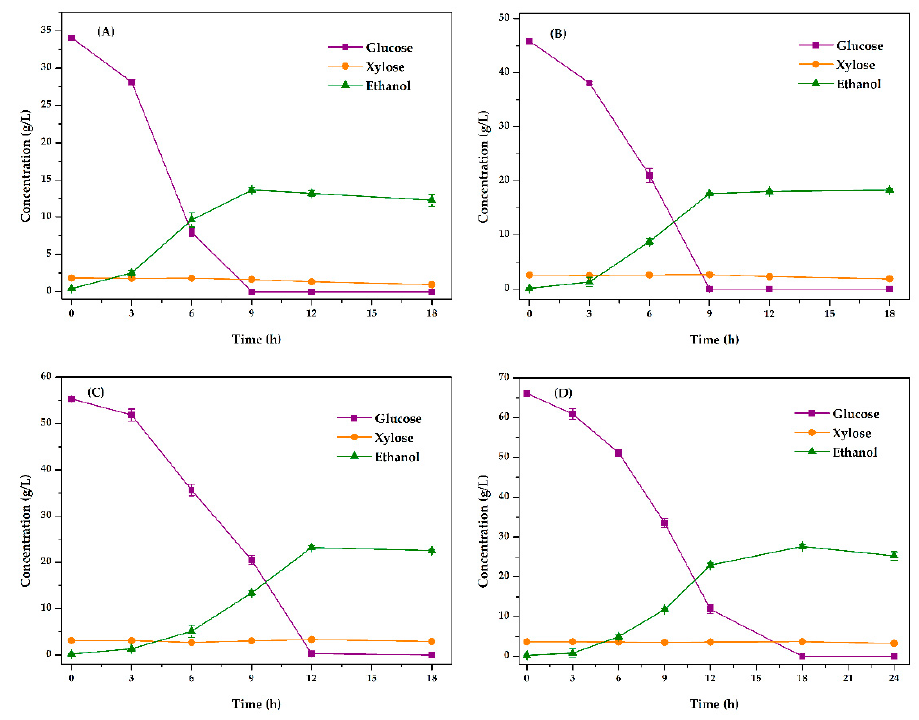
Figure 6. The results of SHF under different fermentation substrate content. ( A ) Solids content of 8% ( w/v ), ( B ) solids content of 12%, ( C ) solids content of 16%, and ( D ) solids content of 20%.